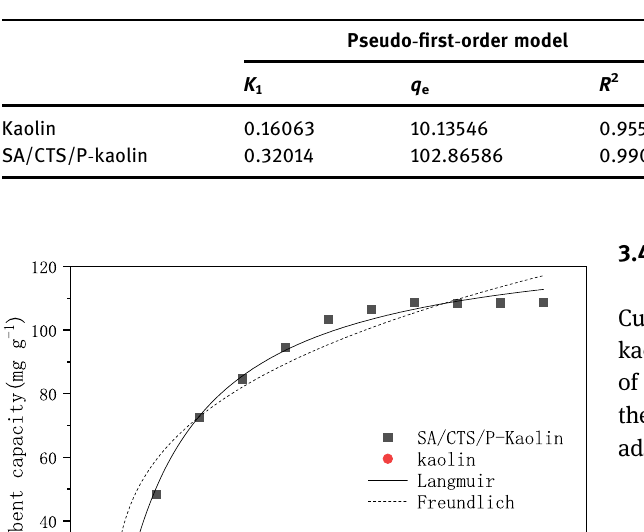
Table 2: Kinetic parameters of adsorbent removal of Cu 2 +